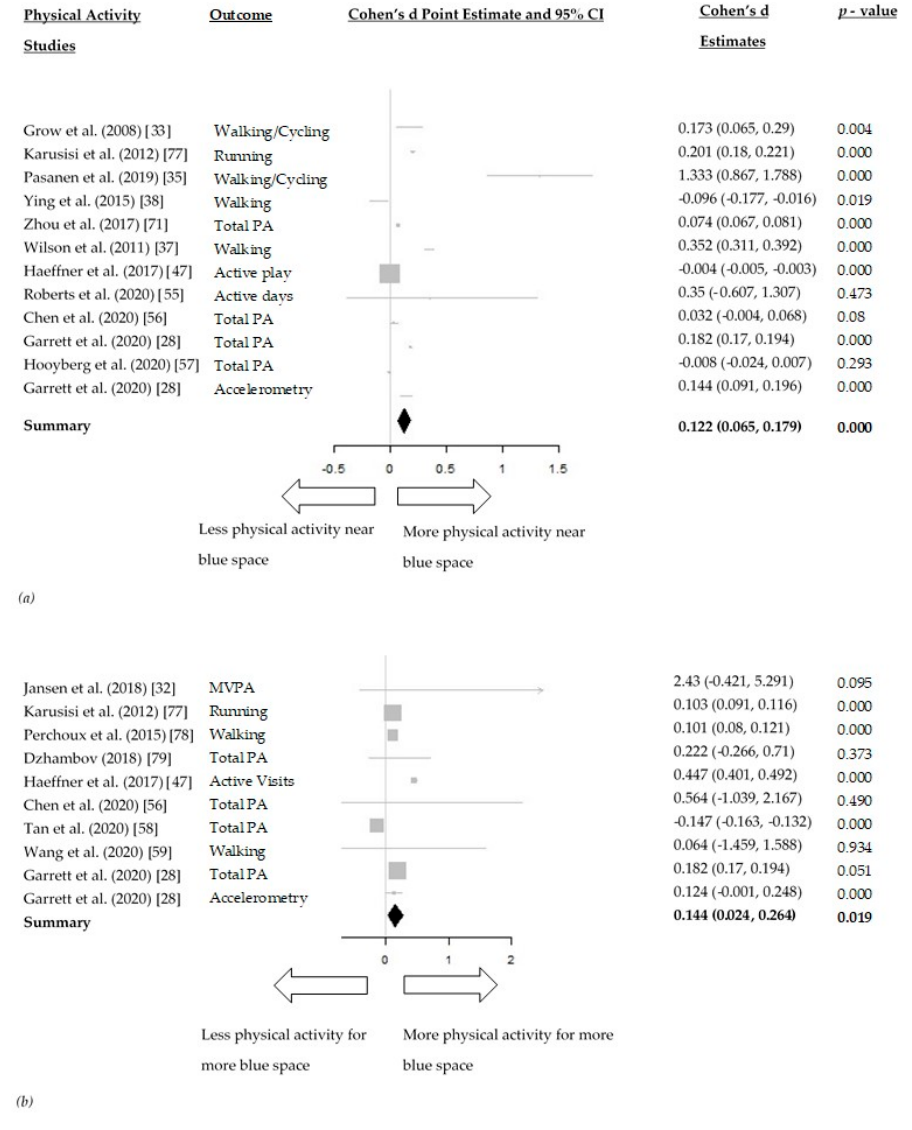
Figure 3. ( a ) Forest plot of the relationships between distance to blue space and physical activity; ( b ) Forest plot of the relationships between the amount of blue space around a certain geographical area and physical